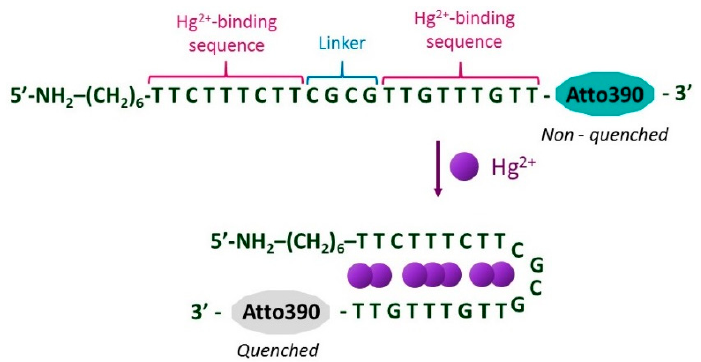
Figure 2. Schematic representation of the hairpin structure acquired by the ON sequence in the presence of Hg 2+ ions due to the formation of T–Hg 2+ –T mismatches, which also quenches the luminescence emission of the fluorophore